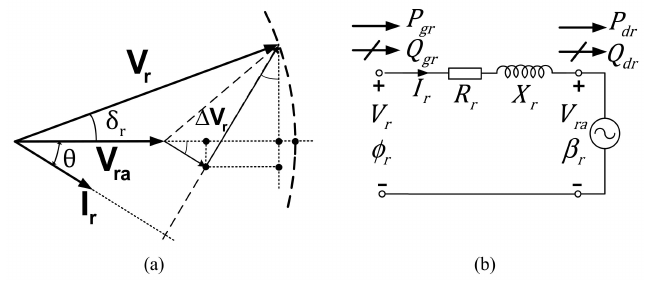
Figure 3. ( a ) Phasor representation and ( b ) equivalent circuit of the rectifier-VSC operation